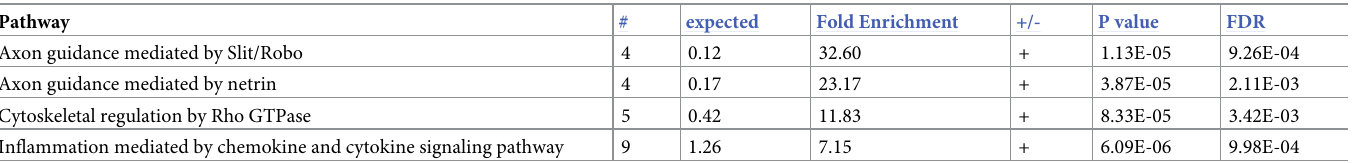
Table 1. Panther pathways for Gain DEG.